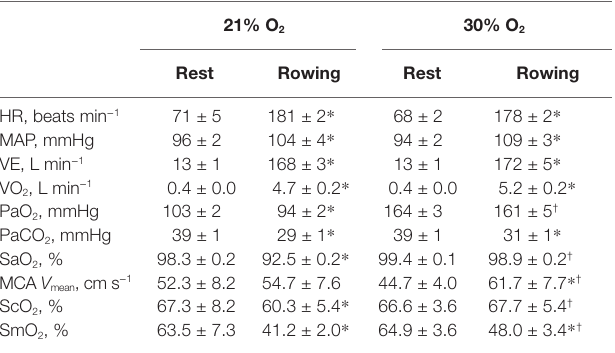
TABLE 1 | Cerebral, cardiovascular, and respiratory variables at rest and over the last 30 s of rowing with normal and hyperoxic air.